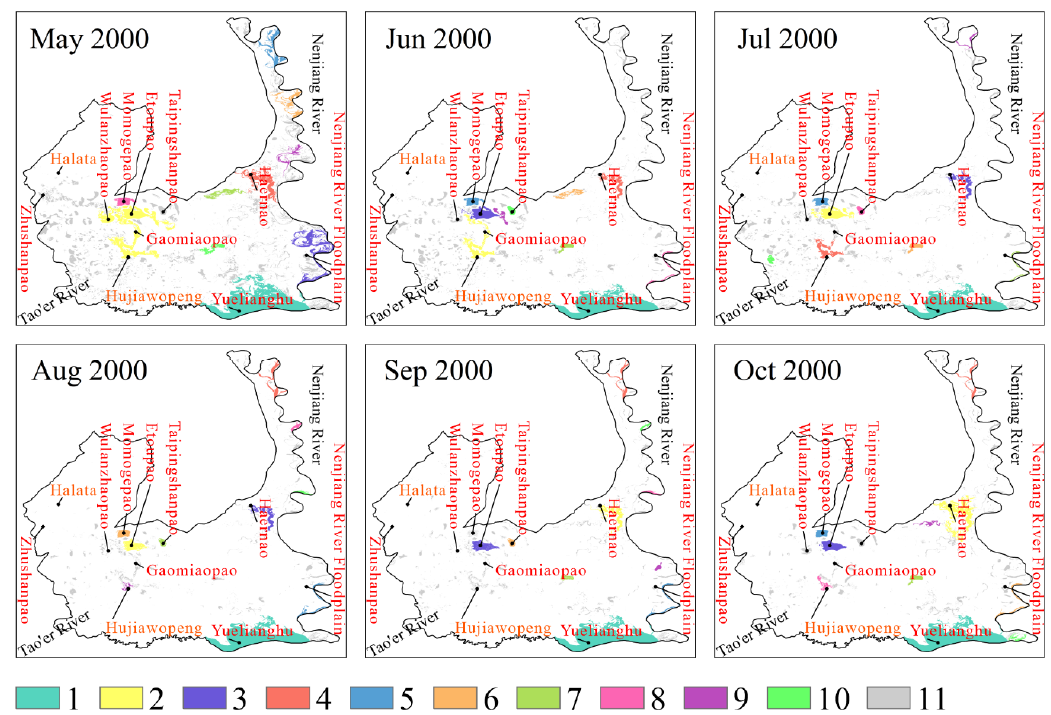
Figure 4. Spatiotemporal distribution of the connectomes in Momoge National Nature Reserve, China during a dry year. Colors 1–10 in the legend refer to the top 10 largest connectomes, and color 11 refers to the remaining connectomes and isolated water bodies. Data source: EC JRC/Google. Water 2020 , 12 , x FOR PEER REVIEW